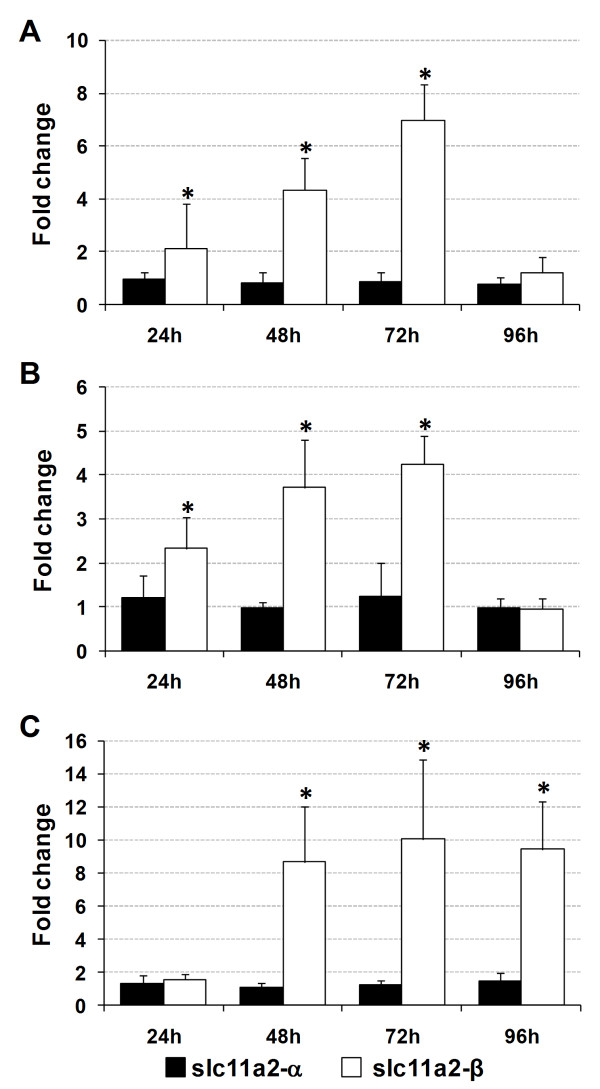
Sea bass slc11a2-α and slc11a2-β expression under experimental infection, in the (A) liver, (B) spleen and (C) head kidney. Values are expressed as mean fold change ± S.D. (n = 5). Samples were collected at 24, 48, 72 and 96 hours post-infection with Photobacterium damselae (1.0 × 105 CFU/fish). β-actin was used as the housekeeping gene. Differences from the control group were considered significant at *p < 0.05.